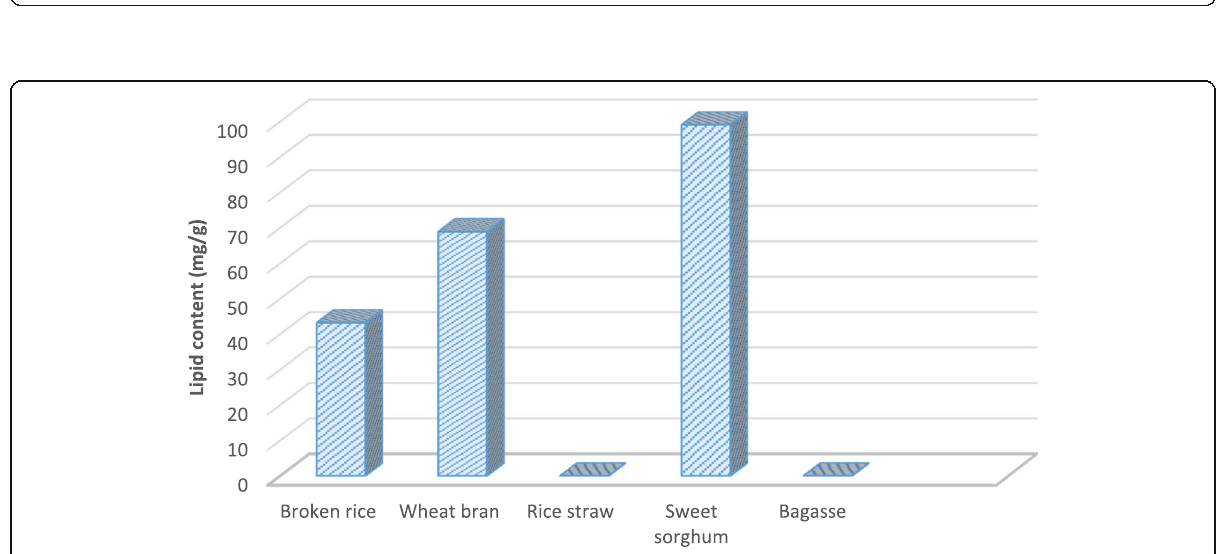
Fig. 3 Lipid production P. commune NRC2016 using different agro-industrial by-products as semi-solid state